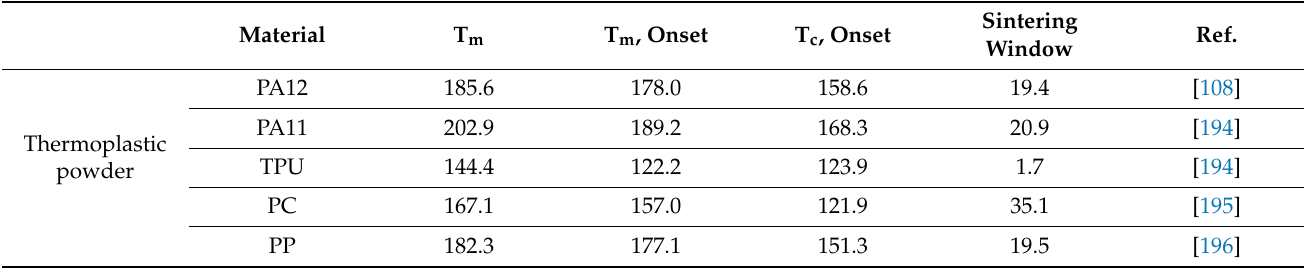
Table 4. Melting temperature, onset melting temperature, crystallization temperature, and sintering window of a few common thermoplastic powders for